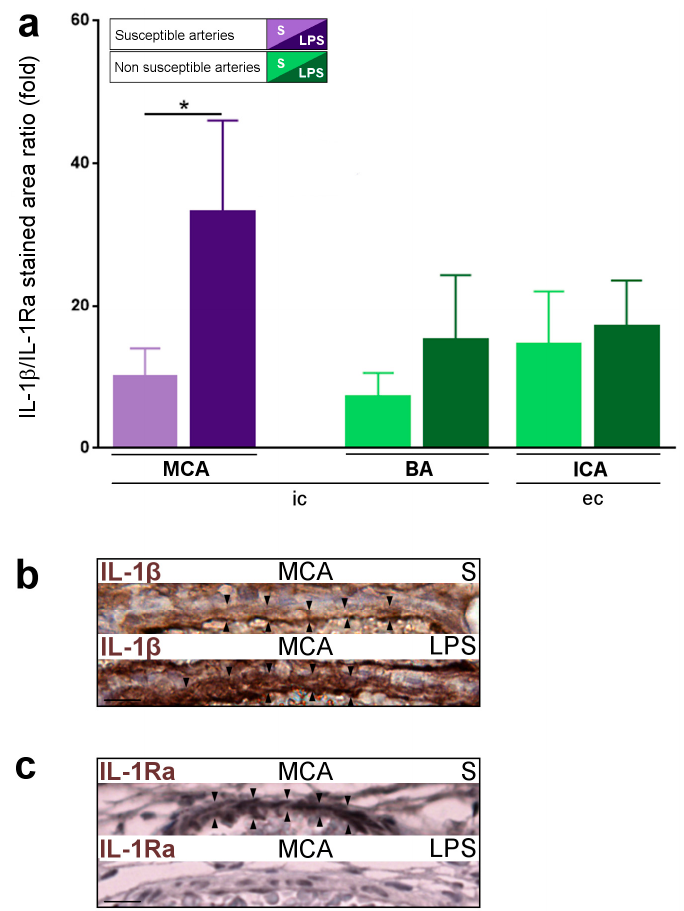
Figure 6. IL-1 β /IL-1Ra pro-inflammatory ratio in LPS-exposed (LPS group) vs. S-exposed (S group) P1 pups: ( a ) increased IL-1 β /IL-1Ra pro-inflammatory ratio in LPS-exposed (LPS group) vs. S-exposed (S group) PAIS-susceptible artery; ( b ) IL-1 β staining (black arrowhead) in a LPS-exposed vs. S-exposed PAIS-susceptible artery (MCA); and ( c ) IL-1Ra staining (black arrowhead) in a LPS-exposed vs. S-exposed PAIS-susceptible artery (MCA). Data are presented as mean ± standard error of the mean (SEM). * p < 0.05, Mann–Whitney test. n = 6–14 arteries from 6–7 animals per condition. Scale bar = 15 µm. Abbreviations: BA, basilar artery; ec, extra-cranial; ic, intra-cranial; ICA, internal carotid artery; IL-1 β , interleukin-1 β ; LPS, lipopolysaccharide; MCA, middle cerebral artery; S, saline.